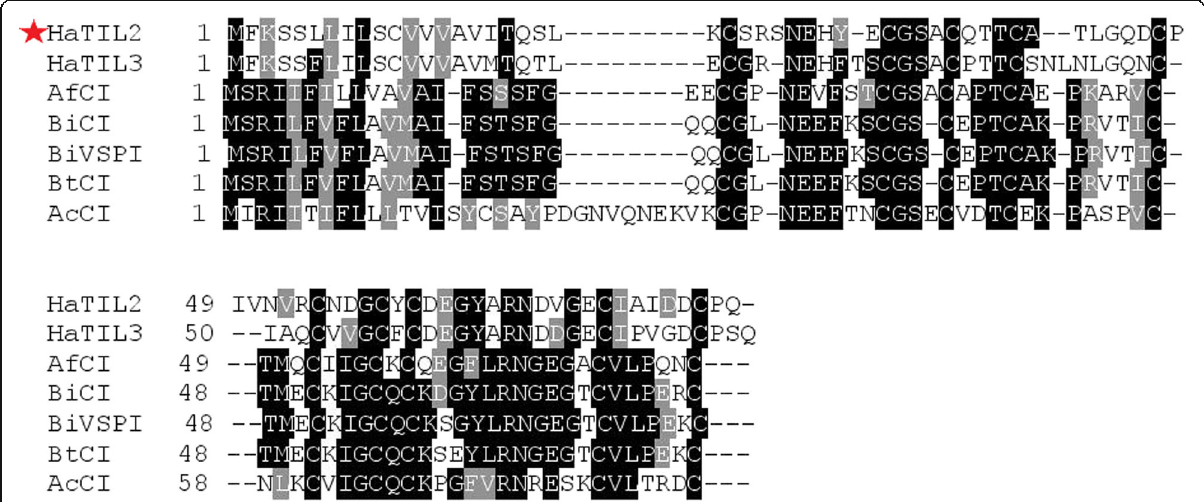
Fig. 1 Alignment of the amino acid sequences between HaTIL2 and other known serine protease inhibitors is shown. The sources of the aligned sequences were Helicoverpa armigera TIL2 (this study, GenBank accession no. MN836536), H. armigera TIL3 (AHX25885.1), A. florea CI